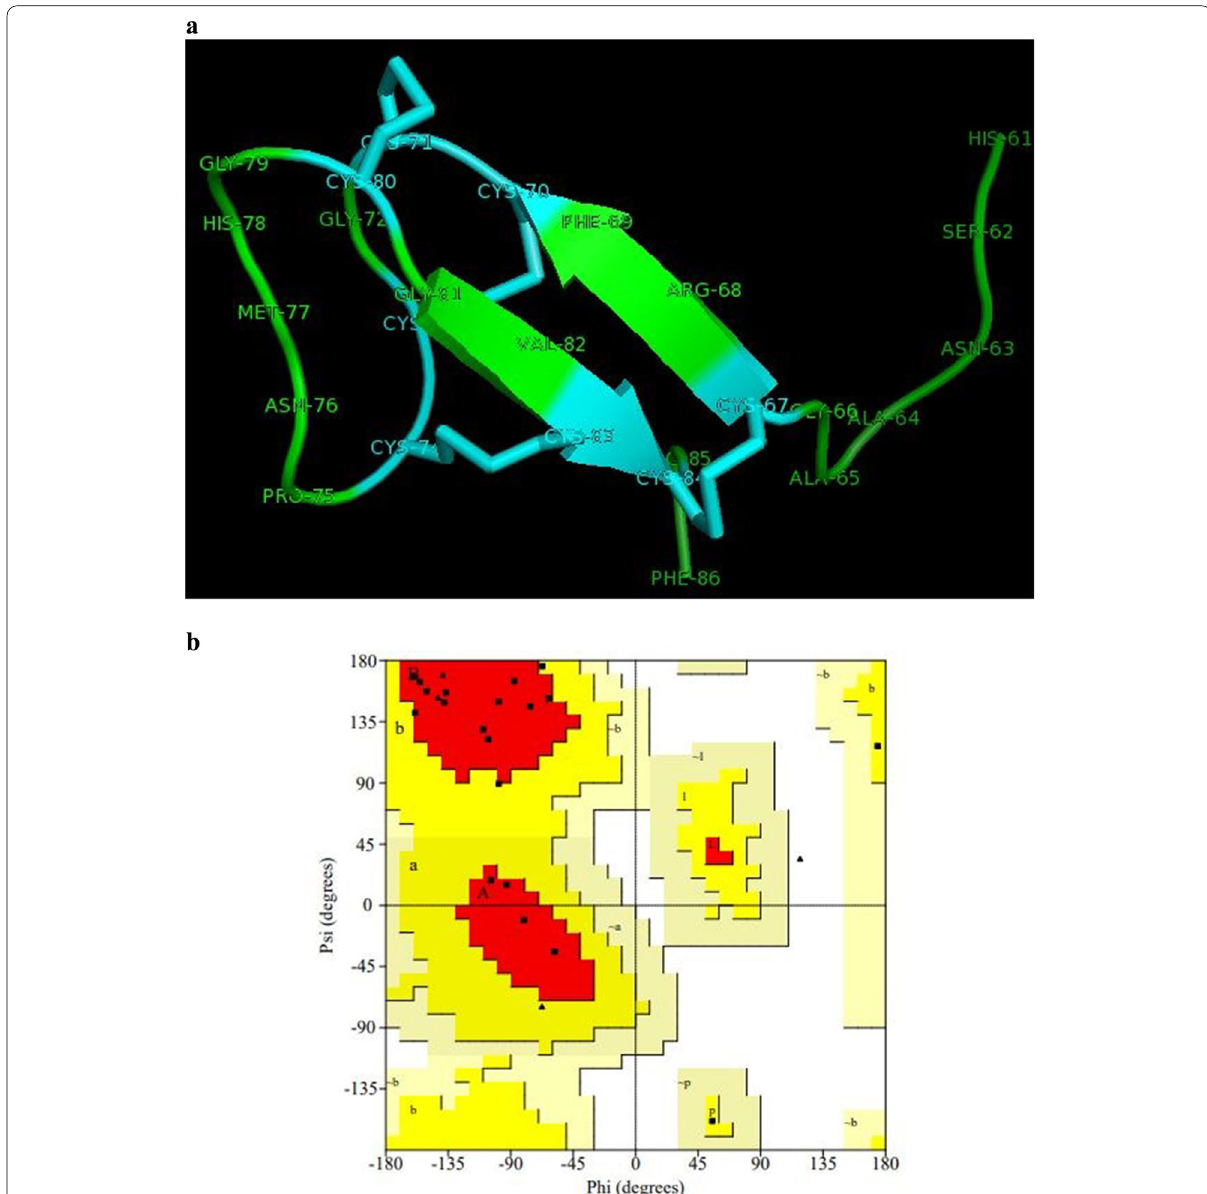
Fig. 3 a Three dimensional structure of Cc -Hep constructed using homology modelling by SWISSMODEL server. Cyan color indicating disulphide bonds. b Ramachandran plot for the predicted three dimensional structure of Cc -Hep using PROCHECK